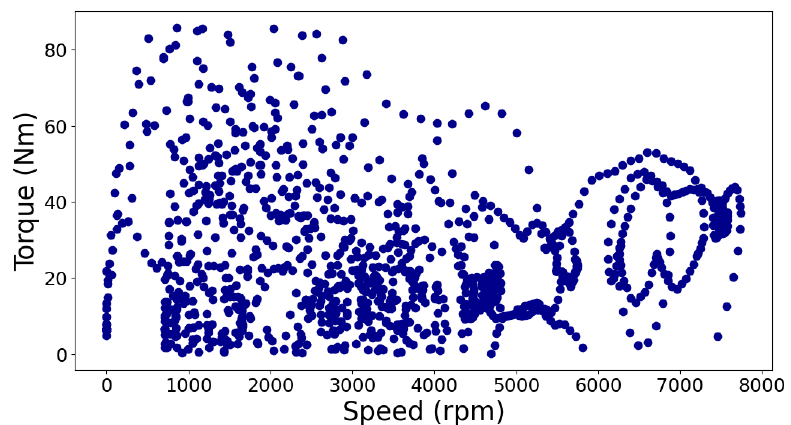
Figure 4. Vehicle torque profile for the WLTP speed